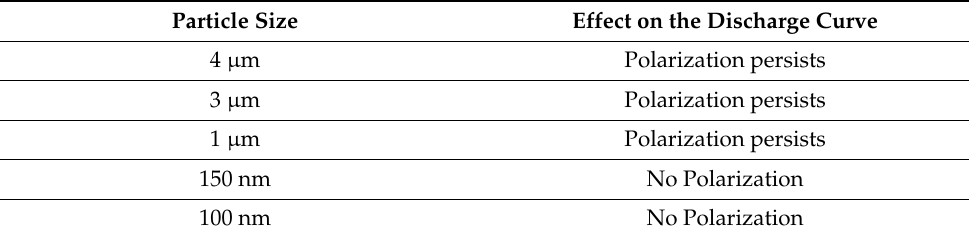
Table 5. Summary of the effect of particle sizes of the Si electrode (with NMC cathode) on the shape of the discharge curve after 2000